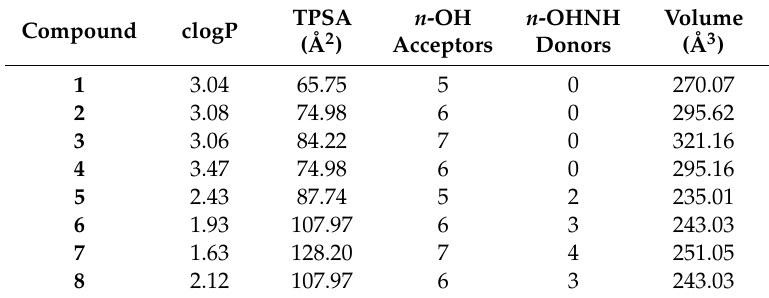
Table 2. Theoretical evaluation of the ADME properties of coumarin–chalcone hybrids. a.